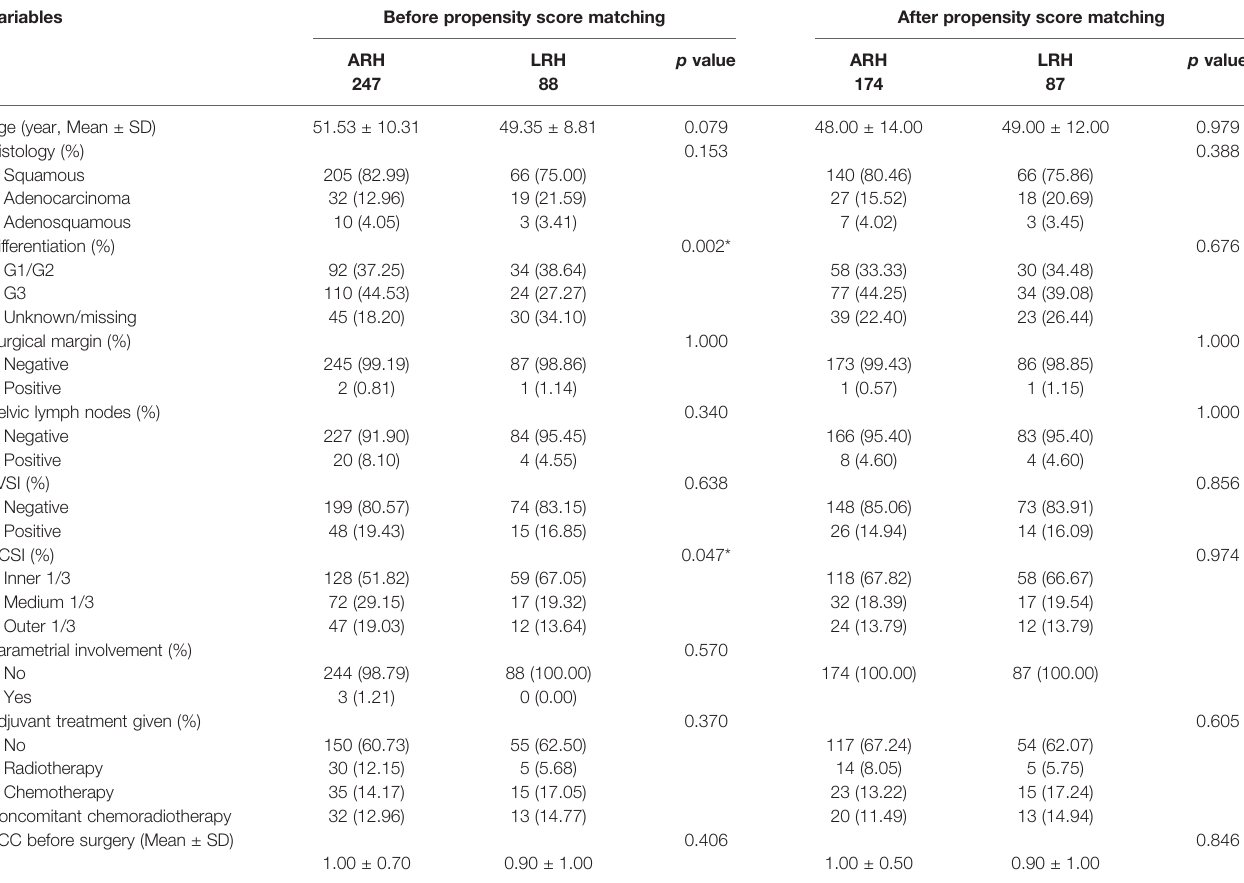
TABLE 1 | Clinicopathologic characteristics before and after propensity score matching. Variables Before propensity score